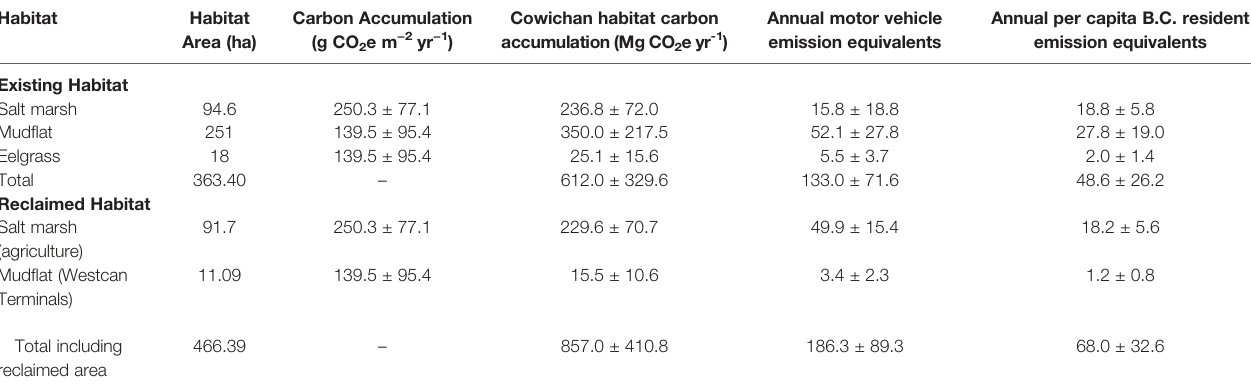
TABLE 6 | Total annual carbon sequestration per habitat in the Cowichan Estuary compared to annual motor vehicle and B.C. resident CO 2 emission equivalents (CO 2